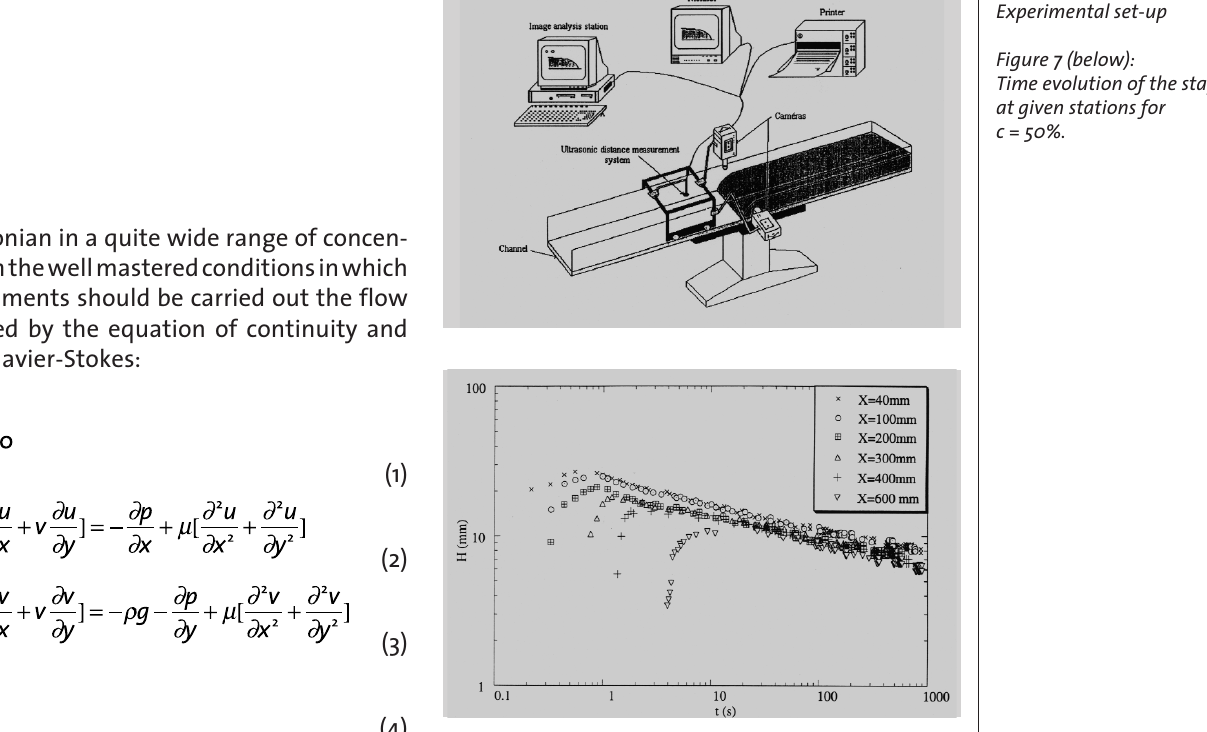
Figure 6 (above): Experimental set-up Figure 7 (below): Time evolution of the stage at given stations for c =